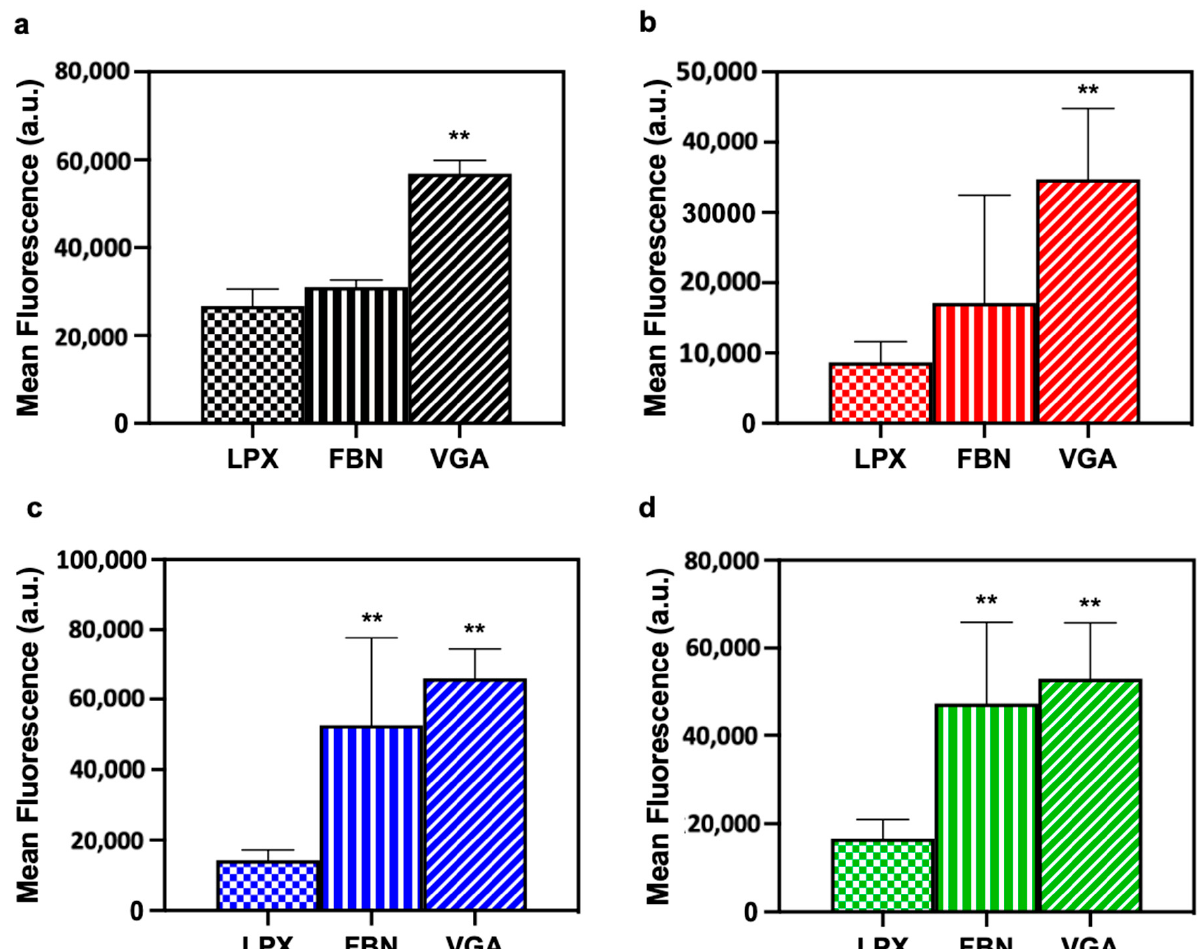
Figure 3. Mean fluorescence acquired by 635 nm laser excitation (filter 655–730 nm) was performed by FACS analysis to assess the uptake by primary corneal epithelial cells following treatment with pristine lipoplexes (LPX), FBN-biocoronated lipoplexes and VGA-biocoronated lipoplexes. LPX1( a ); LPX2 ( b ); LPX3 ( c ); LPX4 ( d ). Results are given as average of N = 3 independent measurements ± standard deviation. Statistical differences were determined by Student’s t test: p < 0.001 was consider strongly significant (**).